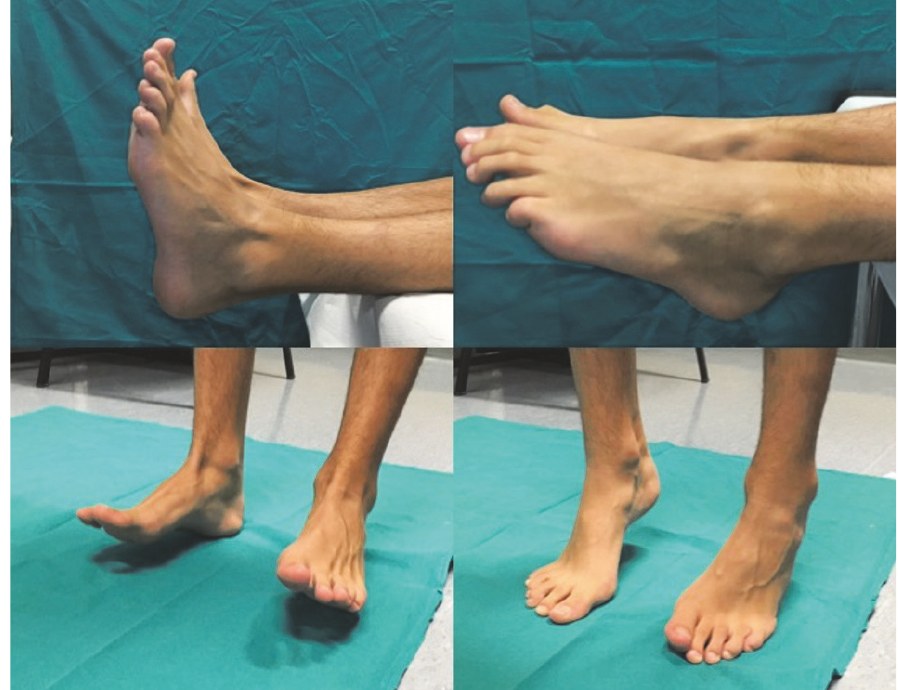
Figure 10: Range of motion and clinical findings at the 5-year